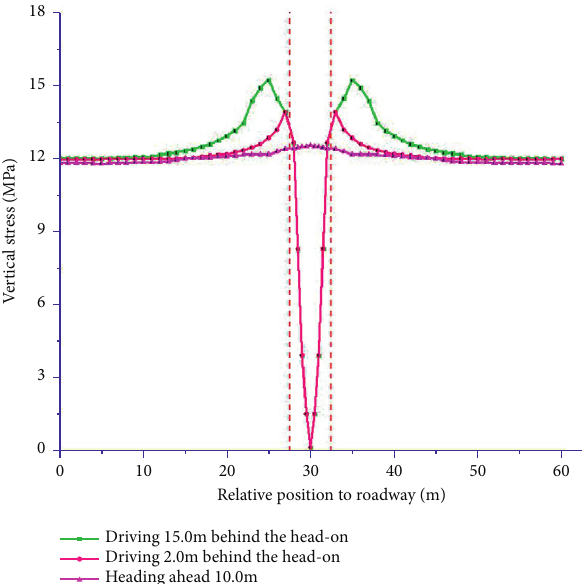
Driving 15.0m behind the head-on Driving 2.0m behind the head-on Heading ahead 10.0m Figure 14: Radial and vertical stress distribution at different sections of the